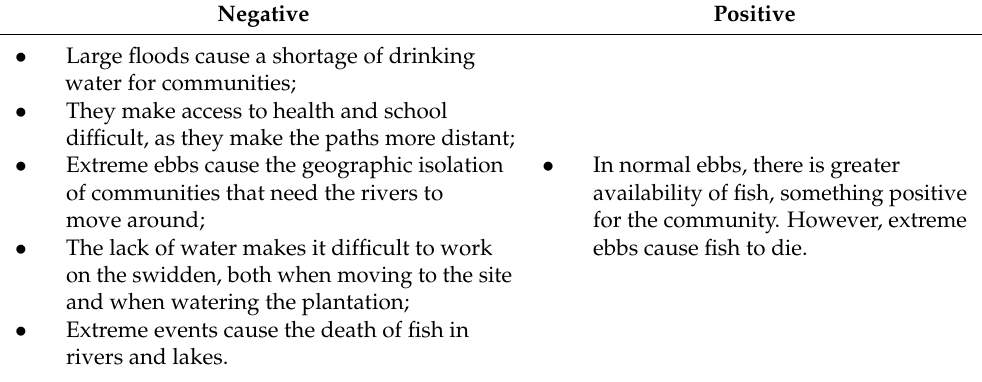
Table 2. Impacts of great